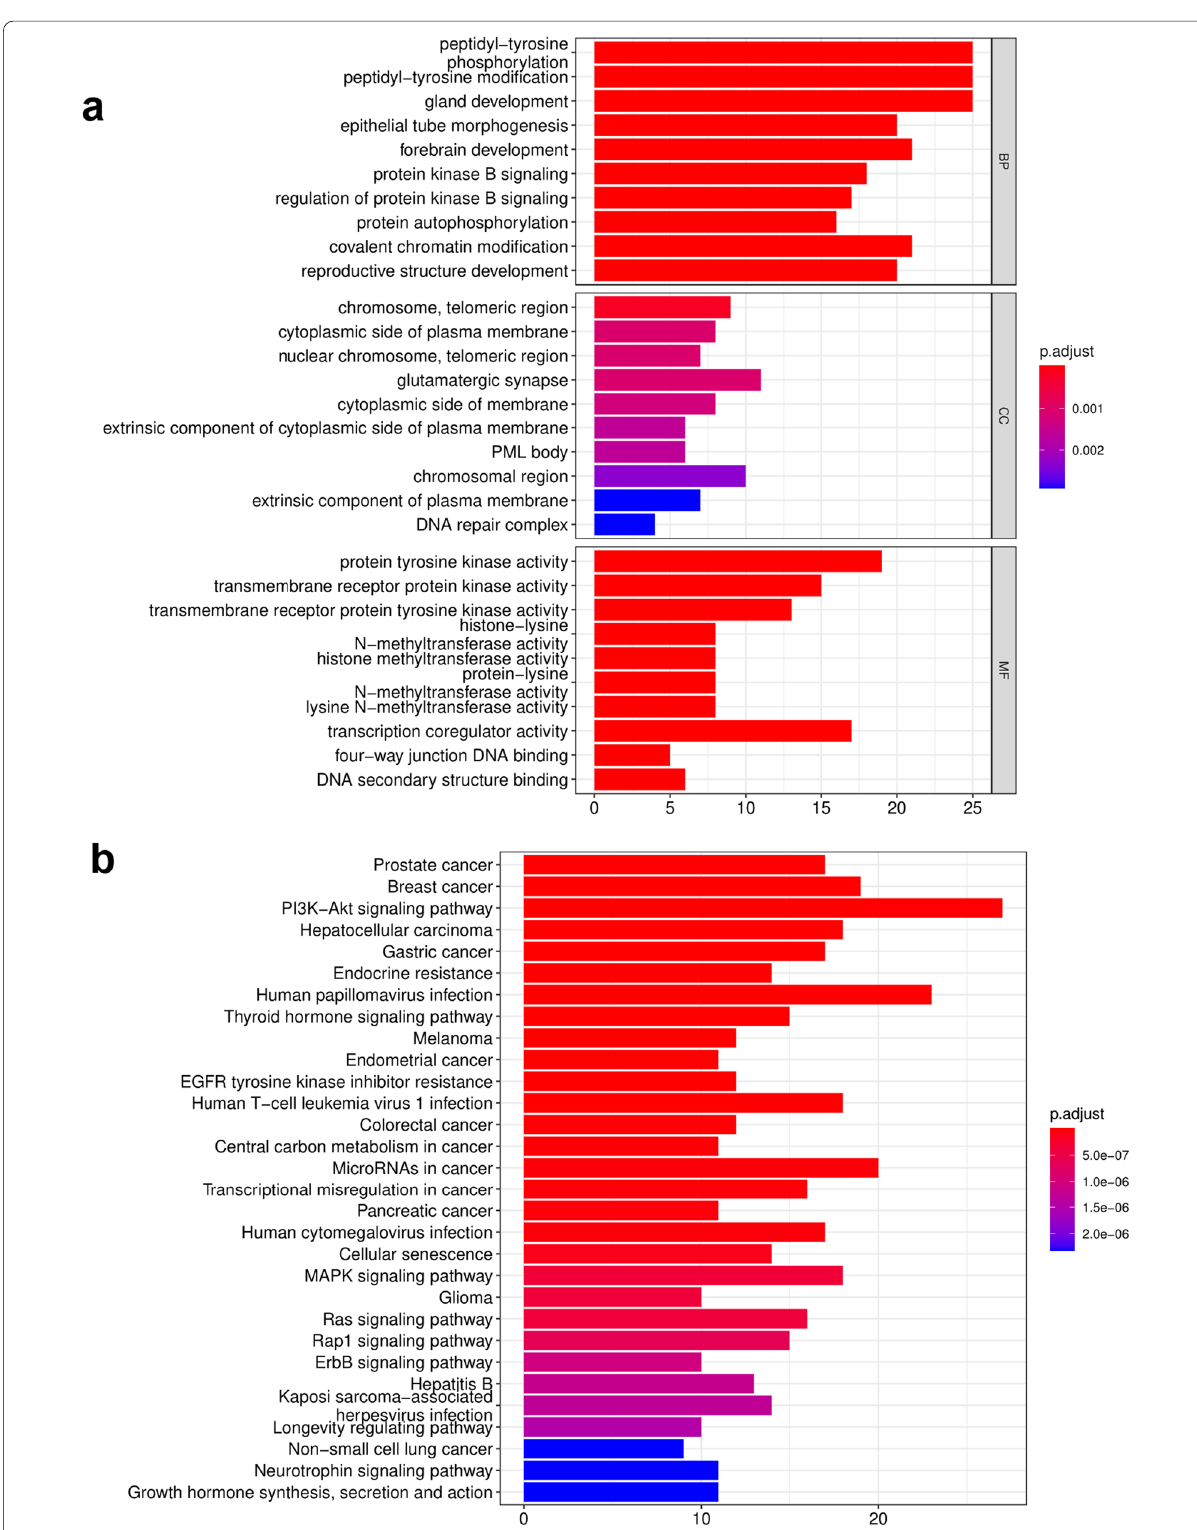
Fig. 3 Enrichment of mutated genes by GO and KEGG analysis. a GO enrichment analysis. b KEGG enrichment analysis. Gene count: the number of mutated genes enriched in this pathway or functional